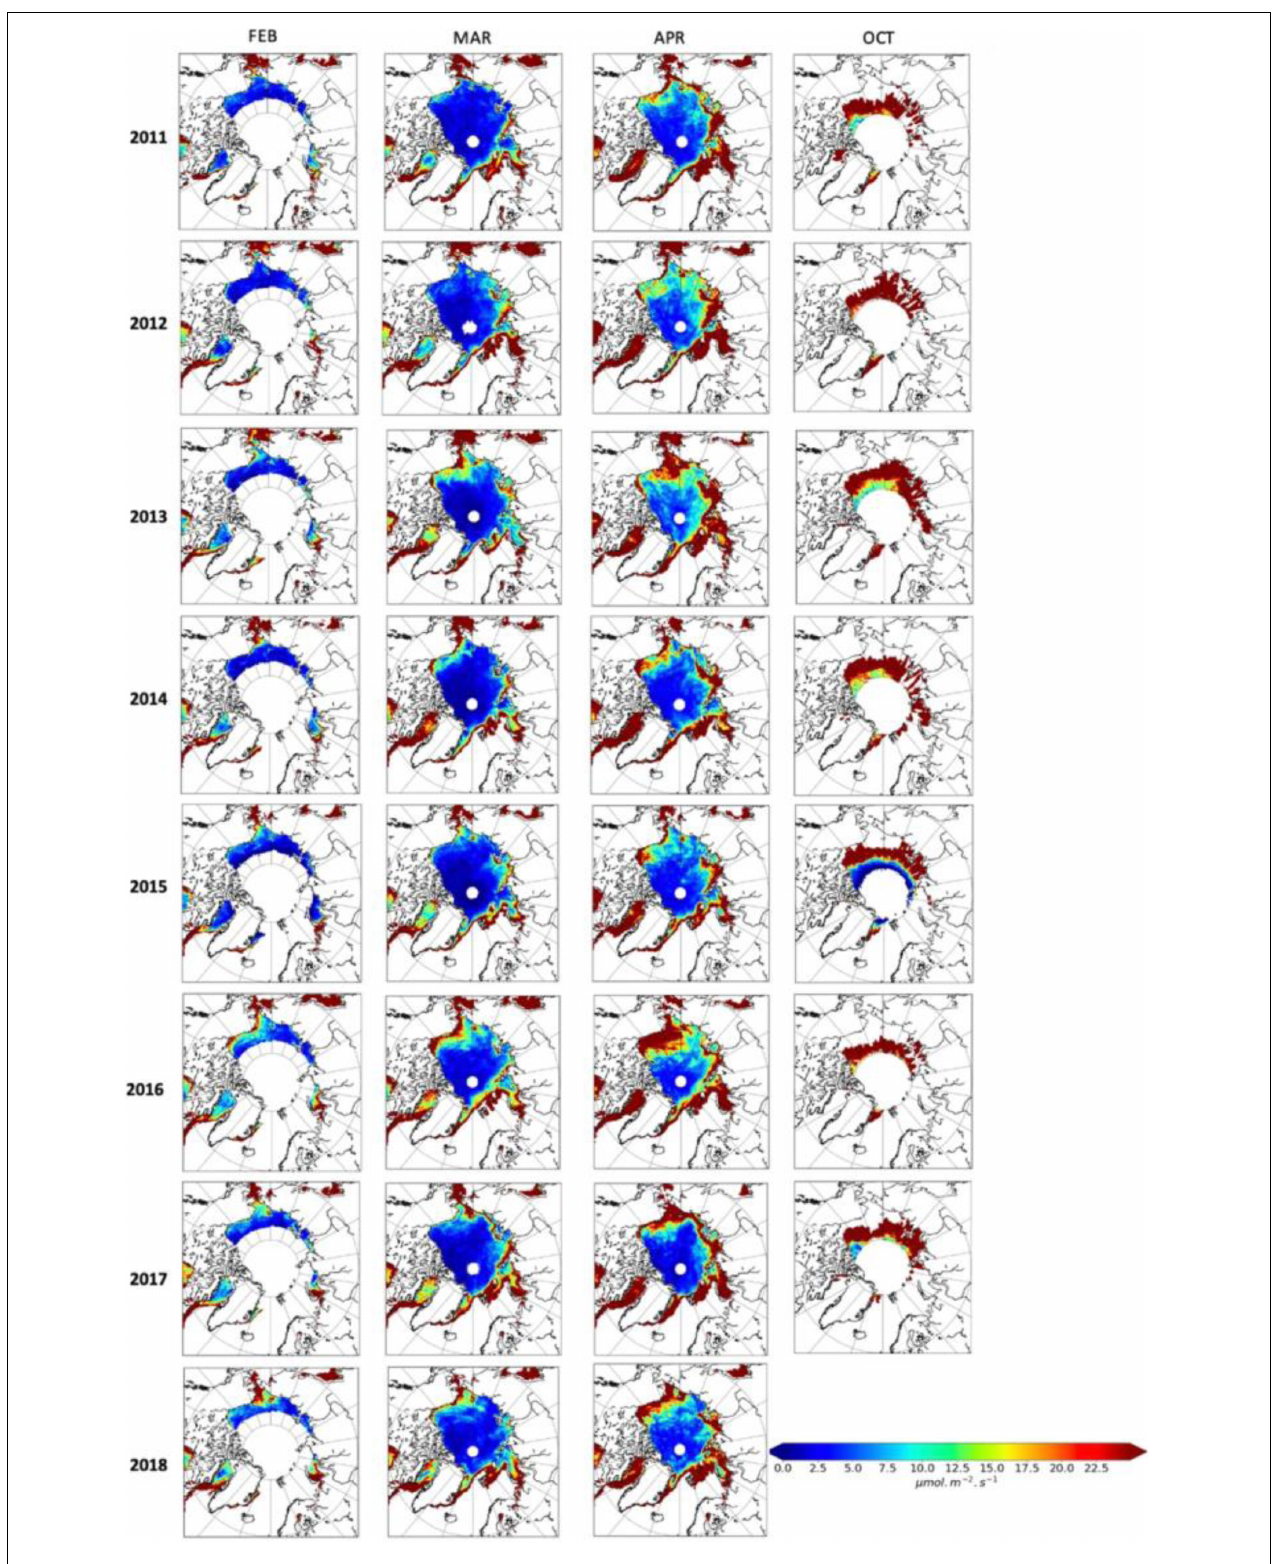
FIGURE 3 | Summary of the monthly mean under-ice PAR maps produced using the satellite-derived sea ice and modeled snow depth data for all months and all years from February 2011 to April 2018.